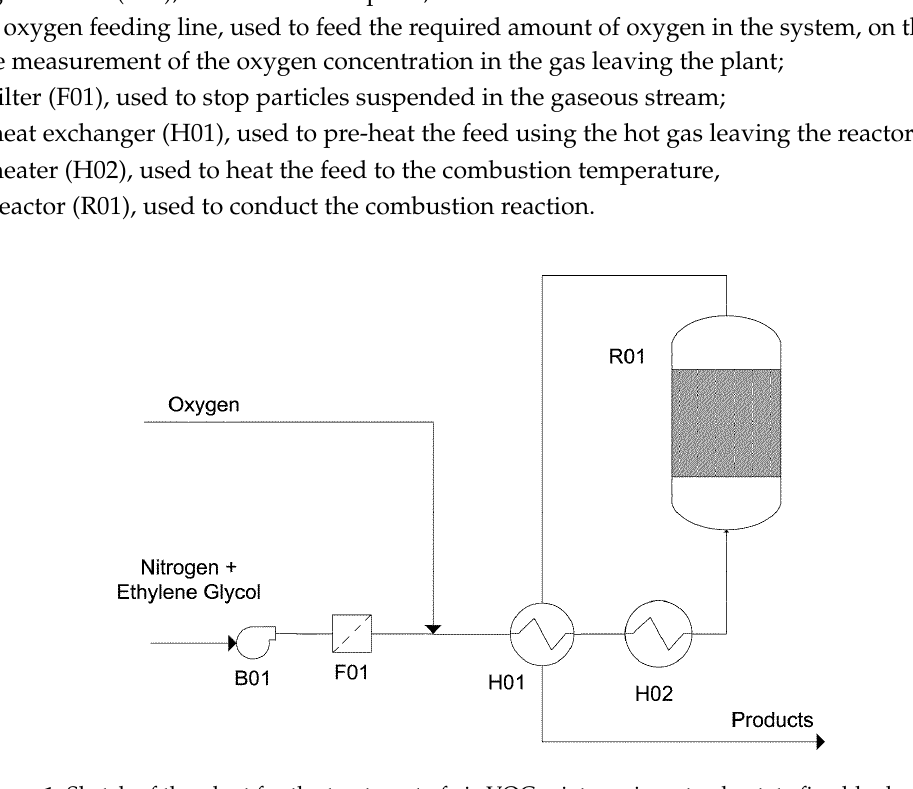
Figure 1. Sketch of the plant for the treatment of air-VOC mixtures in a steady-state fixed-bed reactor.